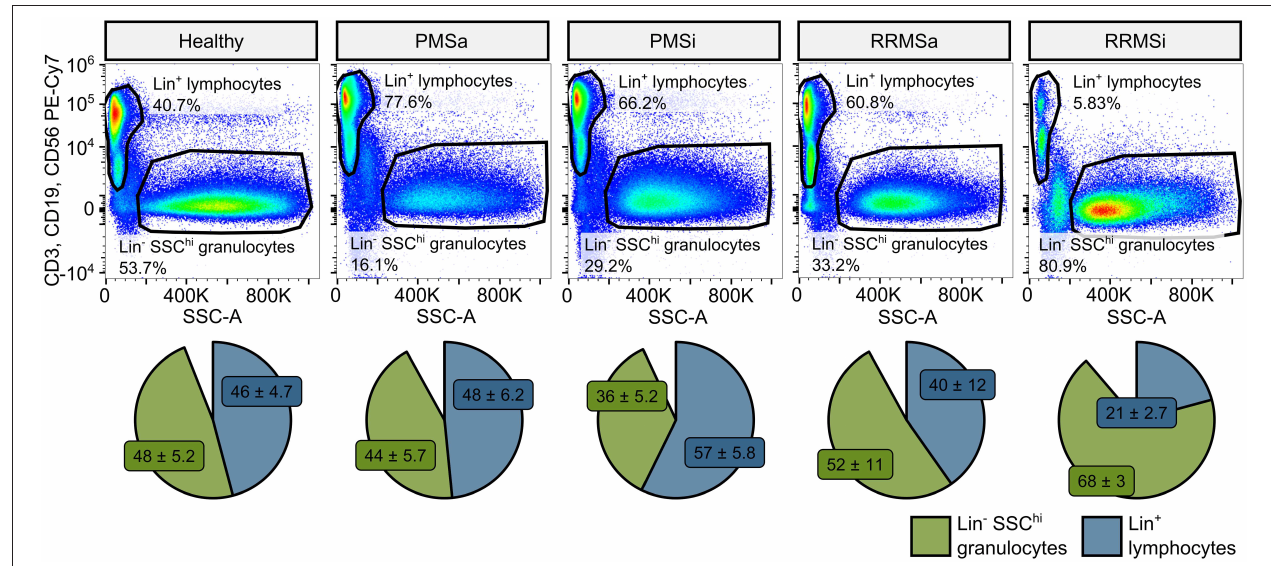
FIGURE 2 | Expansion of granulocytes and shrinkage of the lymphoid compartment in inactive relapsing-remitting multiple sclerosis (RRMSi) individuals. Lineage + lymphocytes and Lineage − SSC hi granulocytes were identified in whole-blood samples from healthy controls ( n = 15) and MS patients stratified by disease course type [active progressive MS (PMSa): n = 14, inactive progressive MS (PMSi): n = 13, active relapsing-remitting MS (RRMSa): n = 8, and RRMSi: n = 30] as presented in Supplementary Figure S1 . Representative flow cytometry results with pre-gating for CD45 + cells are shown. Pie plots display levels of lymphocytes and granulocytes expressed as percentage of CD45 + blood leukocytes. Means with SEM are presented.